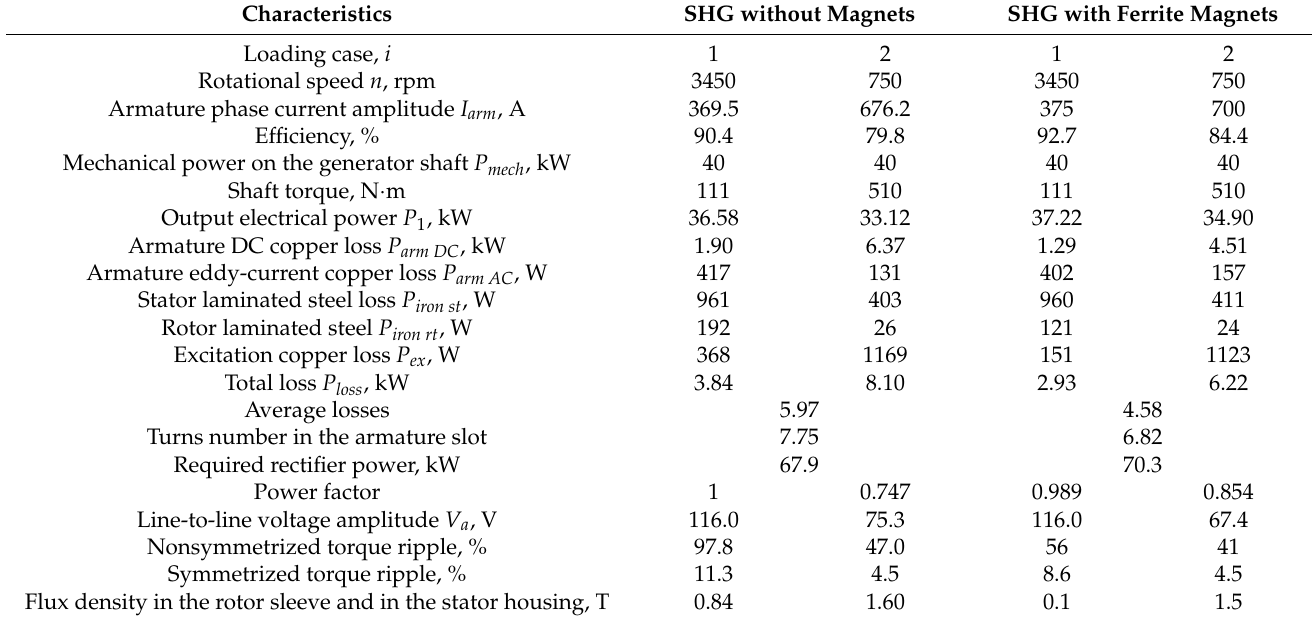
Table 4. Characteristics of generators without magnets and with ferrite magnets.